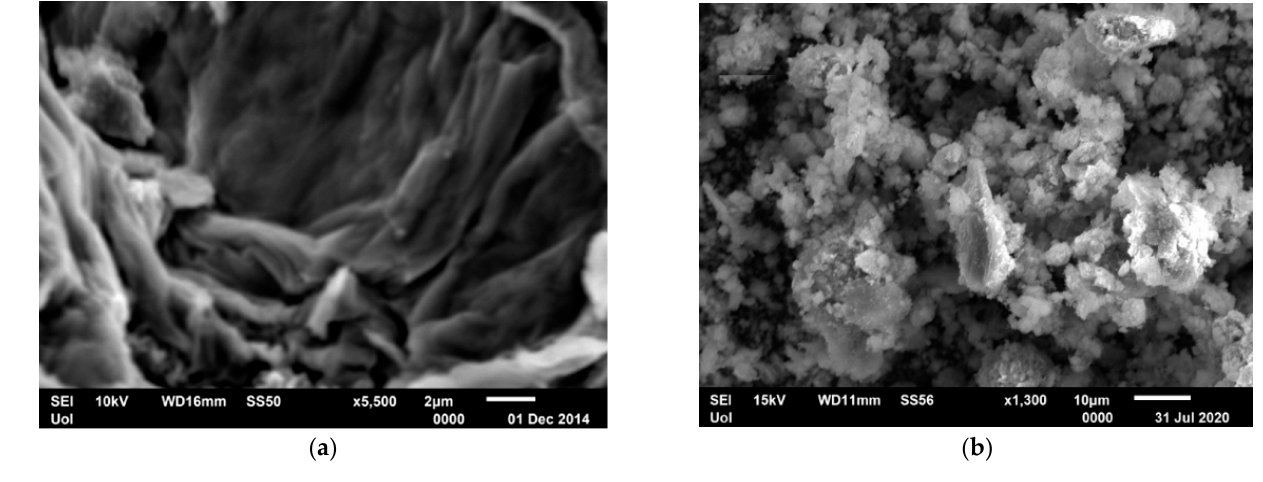
Figure 3. SEM images of ( a ) graphene oxide (GO) and ( b ) mrGO.